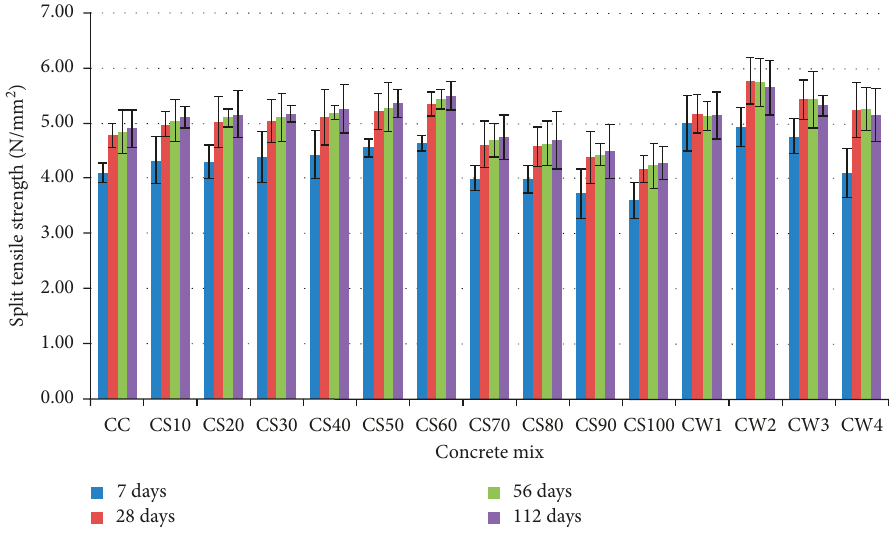
Figure 4: Split tensile strength of concrete mixes at different curing